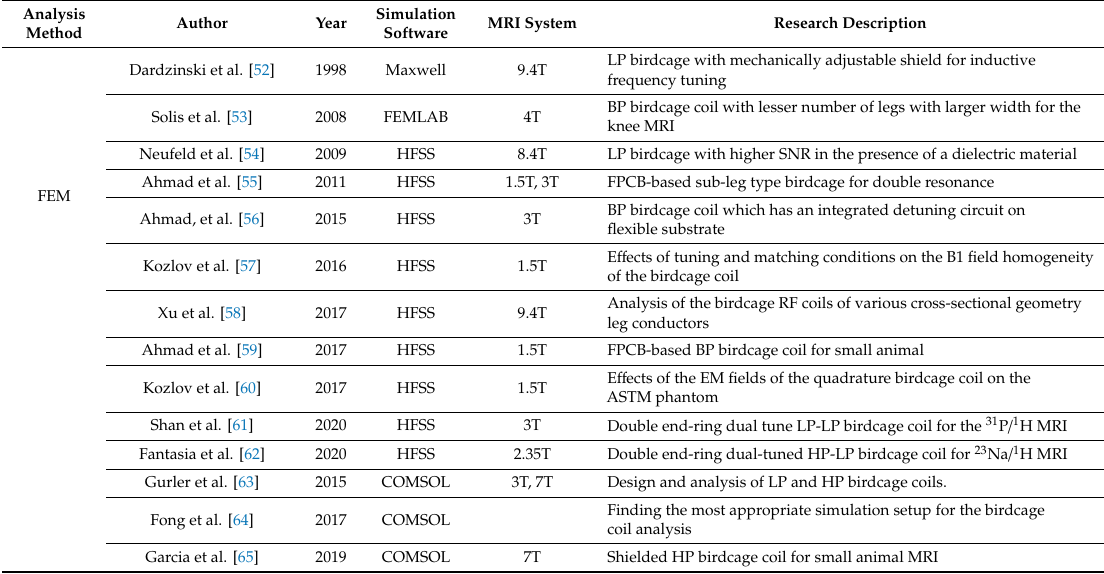
Table 1. Analysis and design process of the birdcage coil using commercially available full-wave three-dimensional electromagnetic (3D EM) simulation